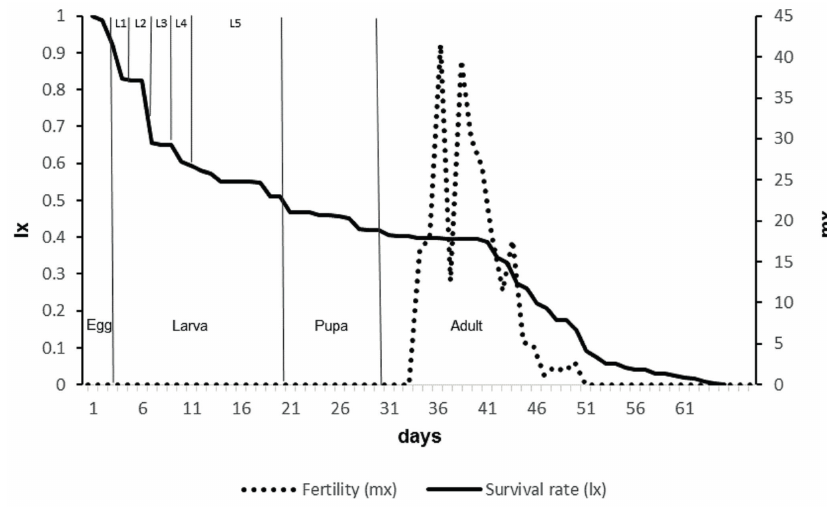
Figure 1 - Relationship between fertility (mx) and survival rate (lx) of Helicoverpa gelotopoeon reared with artificial diet at 25 ± 2º C, 70-75% RH and